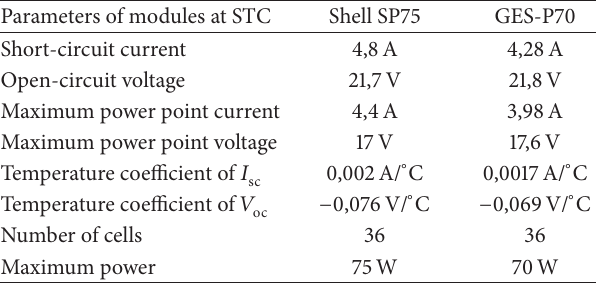
Table 1: Data of the photovoltaic modules used.